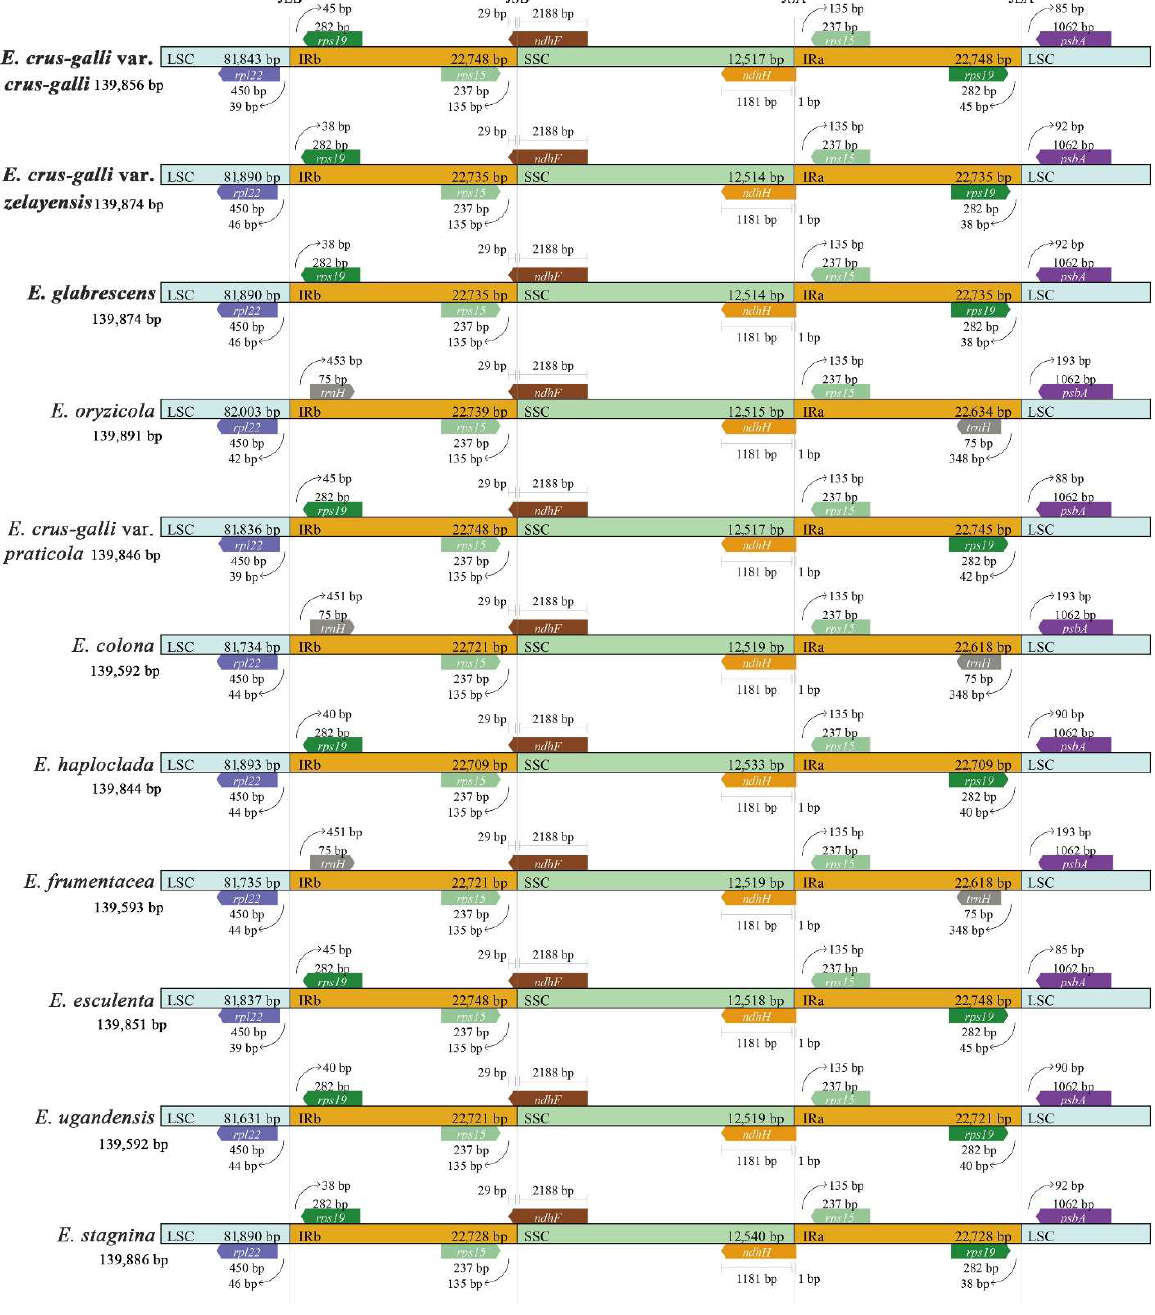
Figure 5. Comparison of LSC, IRb, SSC, and IRa border regions in ten species of Echinochloa spp. The species in bold font were sequenced in this study.